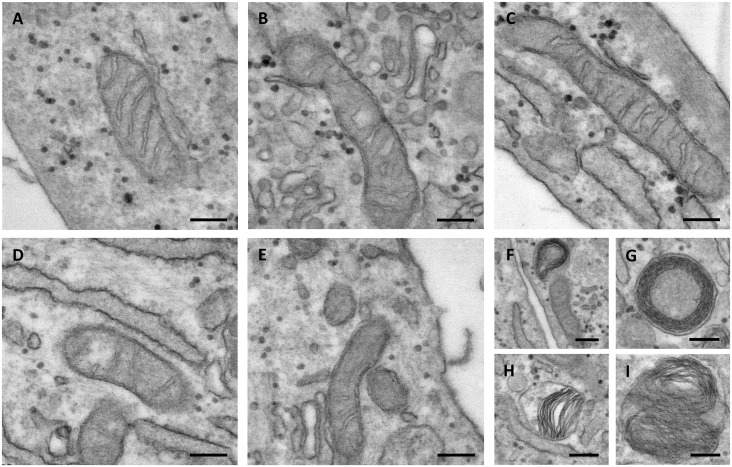
Representative electron microscopy images of mitochondria in control (A–C) and in Pseudoxanthoma elasticum fibroblasts (D–I). In pathologic cells, the mitochondria can be observed as exhibiting partial loss of cristae (D,E), concentric cristae compartments (“onion-like”) (F,G), warped cristae located on one side of the mitochondria (H), and multiple overlaid layers of outer and inner membranes generating two separate compartments (I). Bar = 200 nm.